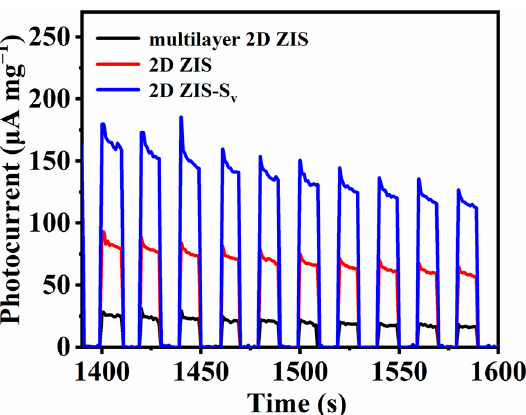
Figure 5. EIS of 2D ZIS ( A ), 2D ZIS ‐ S v ( B ) , and multilayer 2D ZIS ( C ).